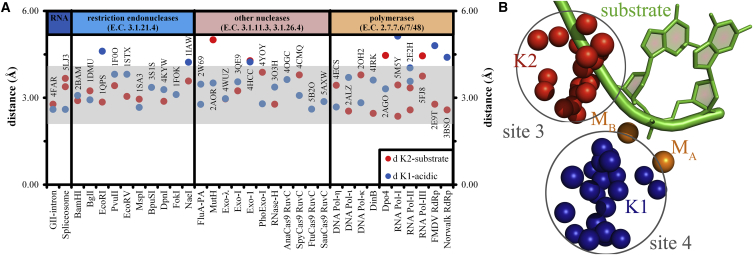
Positioning of K1- and K2-like Elements with Respect to the Two-Metal-Centered Active Site(A) The plot reports distances in angstroms of K1-like elements from the acidic residues that coordinate MA-MB (d K1-acidic, blue dots) and of K2-like elements from the substrate (d K2-substrate, red dots). The gray shade covers the optimal range of distances for hydrogen bonds and ionic interactions (Ippolito et al., 1990). Several outliers correspond to structures solved at low resolution (i.e., PDB: 5FJ8) or with no metals in the active site (i.e., PDB: 1IAW). For enzymes in which K1 contacts acidic residues indirectly (PDB: 2BAM, 1DMU, 1QPS, and 2ALZ), we reported the closest distance to the linking residue (see also Tables 1 and S1). For structures where K2 is present, but the substrate is not resolved in the PDB file (PDB: 3S1S, 1FOK, 4OGC, 5B2O, and 5AXW), we did not plot any data point (see Tables 1 and S1). In exo-λ structure PDB: 4WUZ, the “d K1-acidic” and “d K2-substrate” data points overlap and only the blue dot is actually visible. The names of the enzymes are on the x axis, corresponding PDB codes are indicated on top of every data point. Enzymes are arranged by classes and their respective Enzymatic Classification (E.C.) numbers are indicated on the top of the graph.(B) Overlap of the structures reported in (A), aligned manually in Coot using the substrate and the two-metal-ion center as a guide. For clarity, substrate (green cartoon) and MA-MB center (orange spheres) are represented only for endonuclease BamHI. Blue and red spheres represent the position of the K1- and K2-like elements from all structures, respectively. For clarity, we only represent the position of the potassium ion (for ribozymes), of the epsilon nitrogen atom (for lysine residues), or of the guanidinium carbon atom (for arginine residues), as appropriate. Gray circles represent spheres of a radius of 4.0 Å (K1) and 3.5 Å (K2) and identify sites 4 (K1) and 3 (K2), respectively, as described in Figure 4 and in the main text.